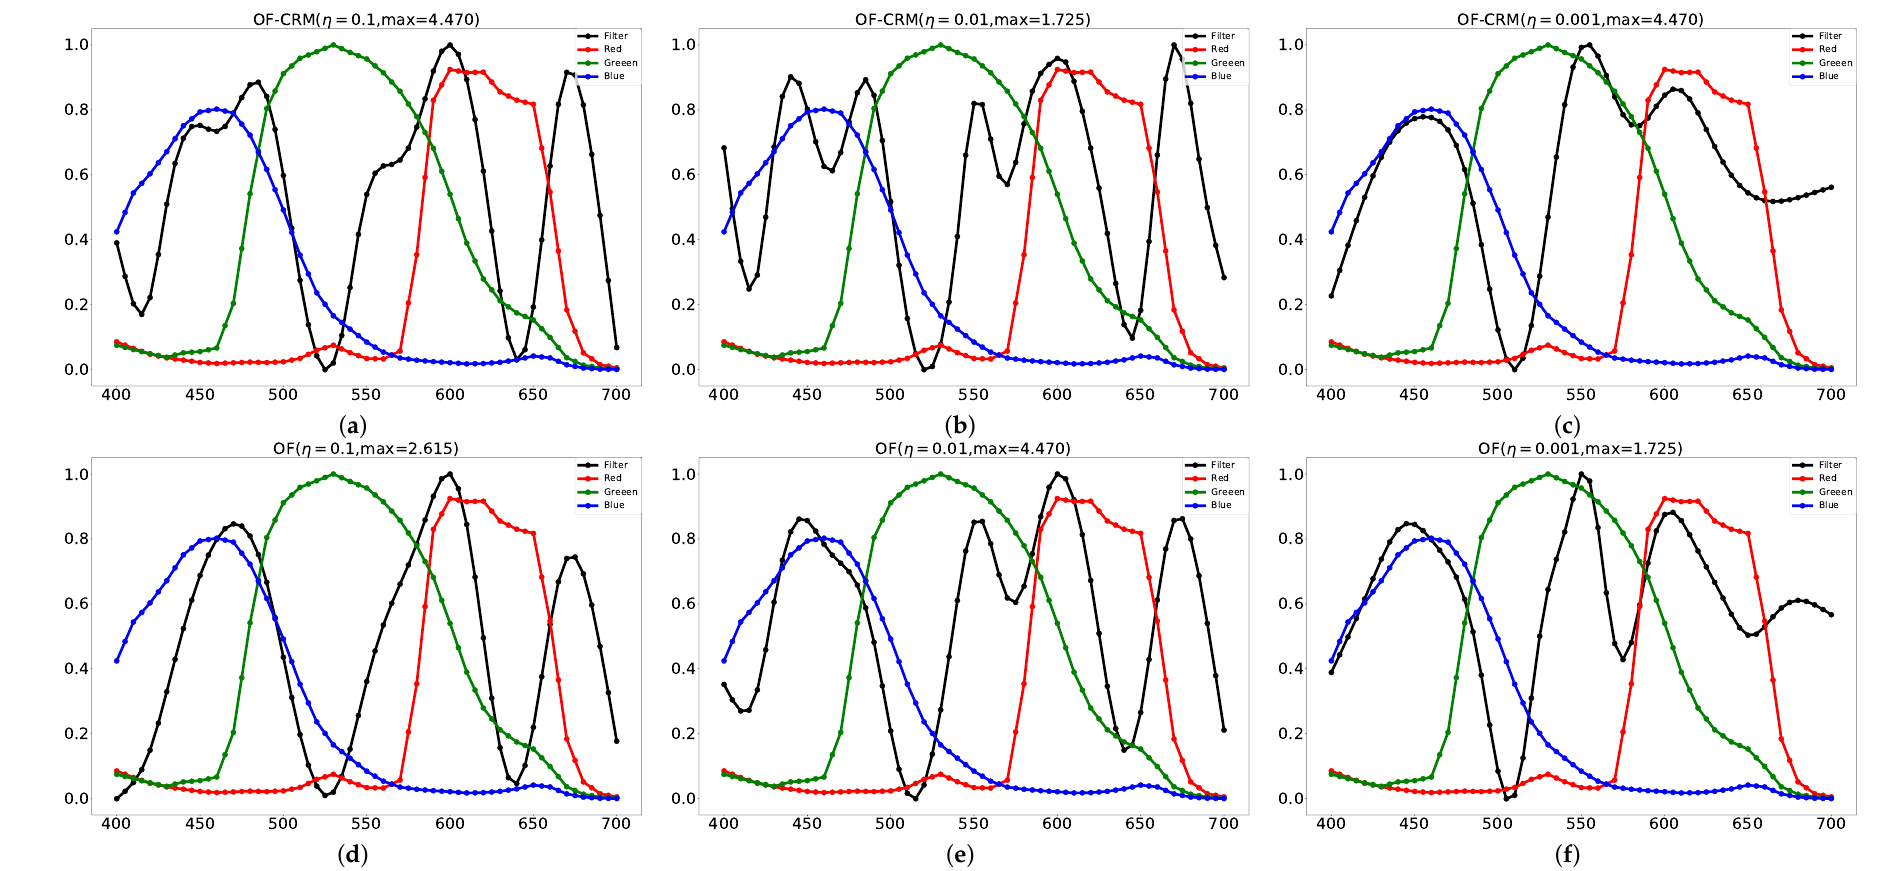
Figure 4. The TR curves of each model is illustrated in the above image. The top row shows the proposed model (with CRM), and the bottom row shows the optical filter design without CRM. In each η setting, we only demonstrate the best model among different max values. ( a ) OF-CRM with smoothness η = 0.1 and max value max = 4.470. ( b ) OF-CRM with smoothness η = 0.01 and max value max = 1.725. ( c ) OF-CRM with smoothness η = 0.01 and max value max = 1.725. ( d ) OF with smoothness η = 0.1 and max value max = 2.615. ( e ) OF with smoothness η = 0.01 and max value max = 4.470. ( f ) OF with smoothness η = 0.001 and max value max =